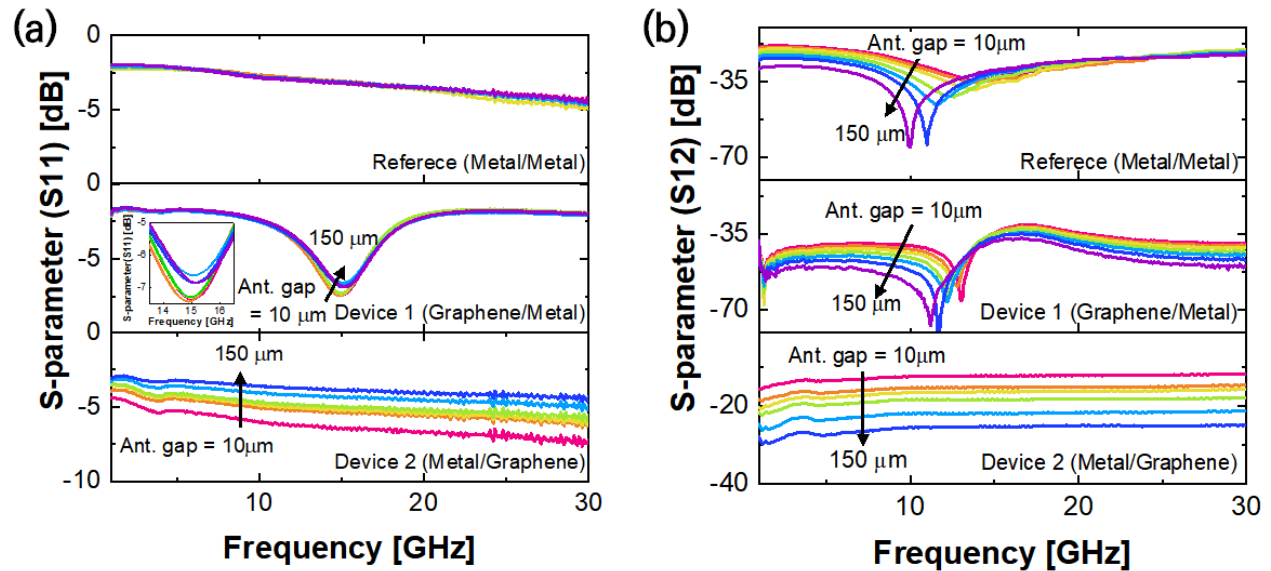
Figure 2. S-parameter measurement results based on the distance between the three antennas. ( a ) Reflectance (S11) and resonant frequency increase as the gap increases. ( b ) Transmittance (S12) and resonant frequency decrease as the gap increases.